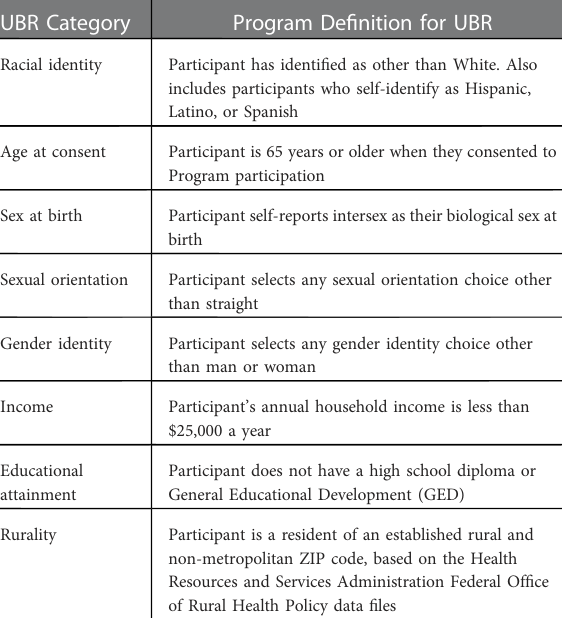
TABLE 1 All of Us de fi nitions for participants that are Underrepresented in Biomedical Research